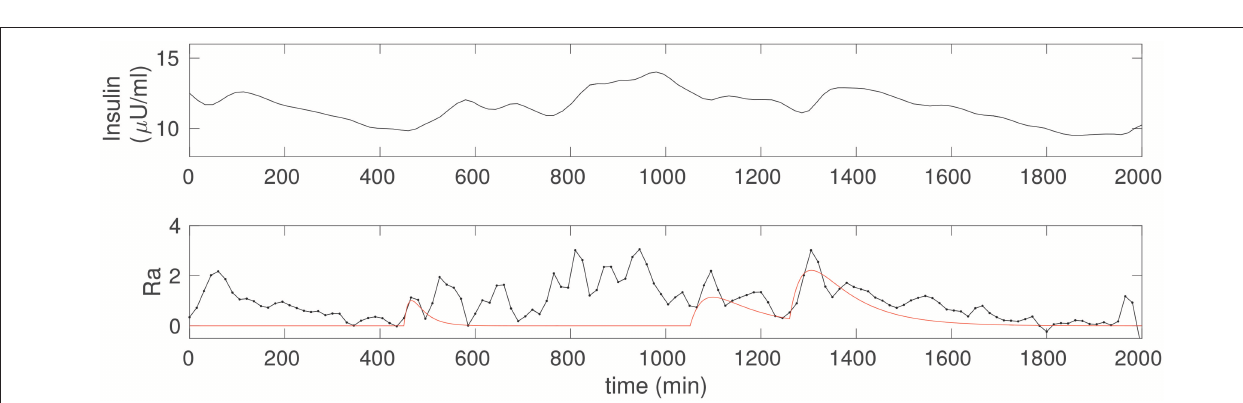
FIGURE 4 | (Upper) The insulin time series corresponding to the non-diabetic glucose from Figure 2 , estimated from the fitted model. Notice that, apart from an initial transient, the insulin is estimated throughout, and this does not require any knowledge of the food input. (Lower) The estimate of the rate of appearance of glucose due to food, Ra (black). The simulation of k gut q gut from Figure 2 is overlaid (red) for